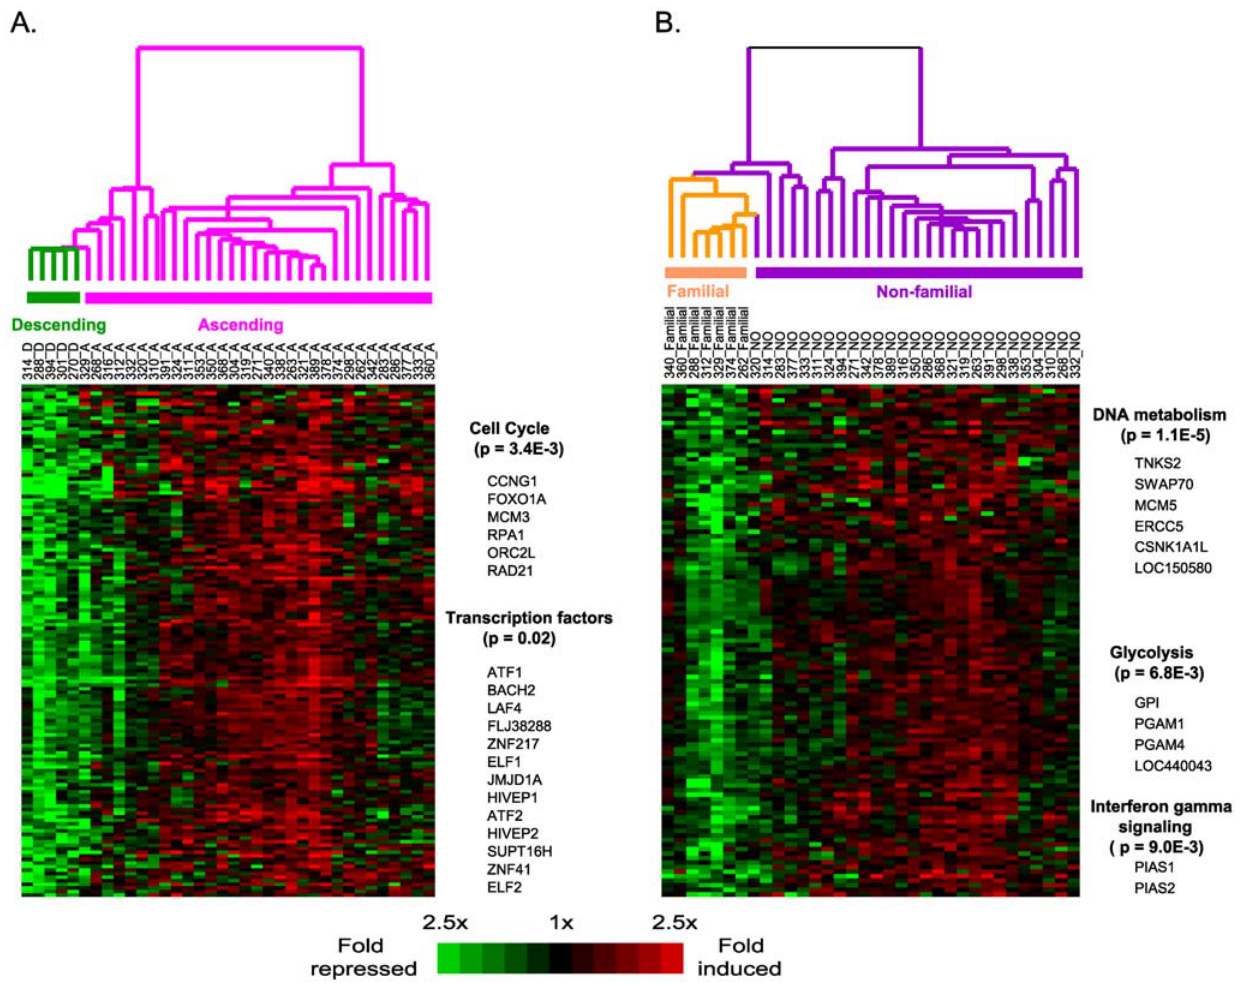
Figure 5. Two-dimensional cluster diagrams. (A).144 signature genes characterizing the ascending and descending TAA subtypes; (B). 113 signature genes characterizing the TAA with or without family history. Representative genes associated with over-represented molecular functions/biological processes/pathways are listed.